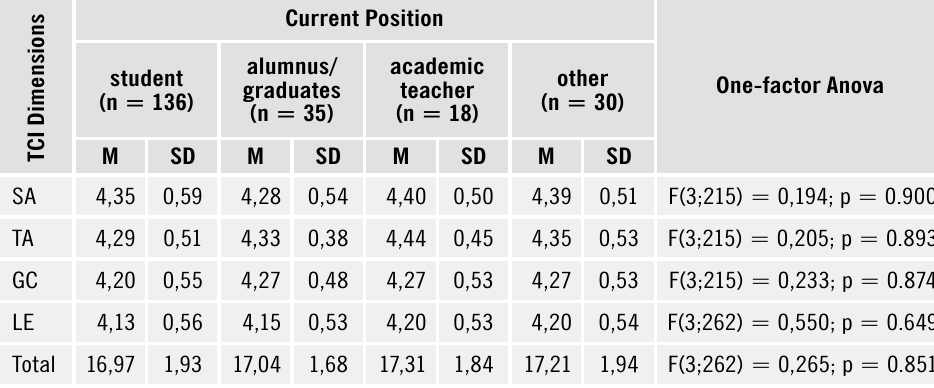
Table 6. Descriptive statistics and the one-factor Anova difference test between respondents of different Current Position for the group from India Current Position (n =